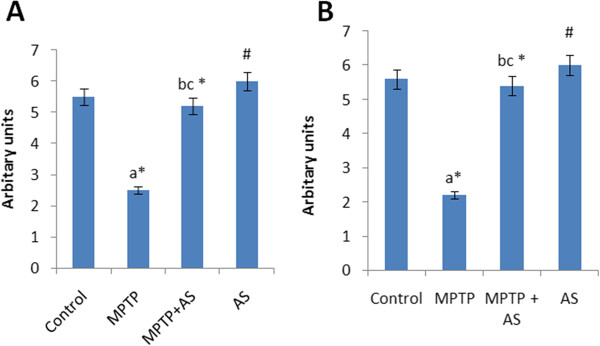
Each bar represented the mean ± S.D of 6 mice. * represents statistically significant at P < 0.05. Comparasion were made as (a) group I vs group II, (b) group II Vs group III, (c) group I vs group III, (#) non significant group I vs group IV (scale bar 50 μm) A: Densitometric pattern of the expression of Bcl 2 in striatum. B: Densitometric pattern of the expression of Bcl 2 in midbrain.